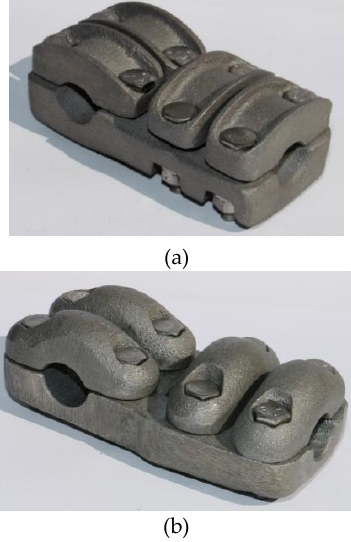
Figure 1. Studied substation connectors from SBI Connectors catalogue. ( a ) Type T, J line; ( b ) Type T, S line.